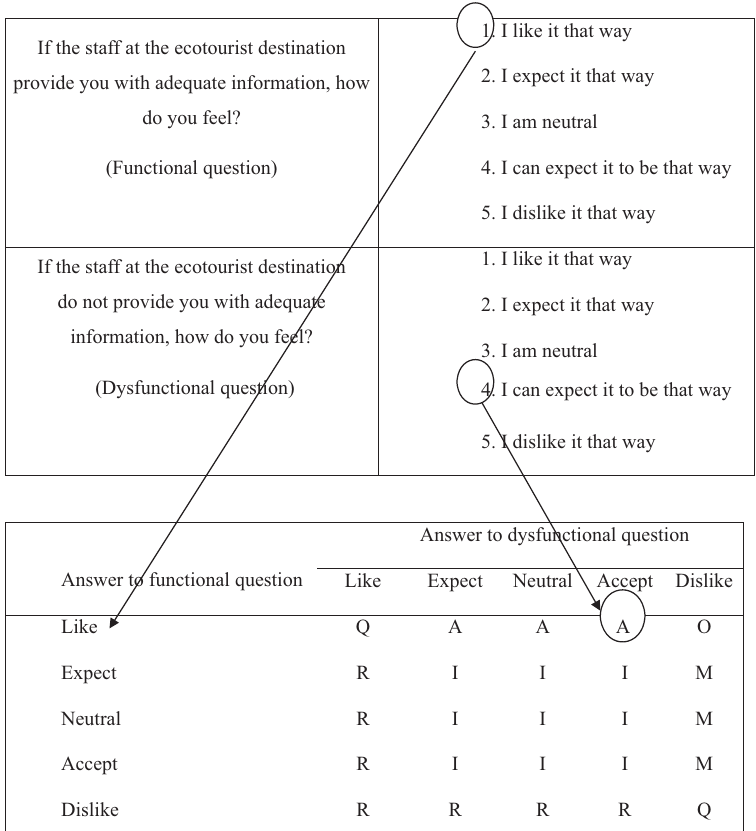
Figure 3. Kano ’ s